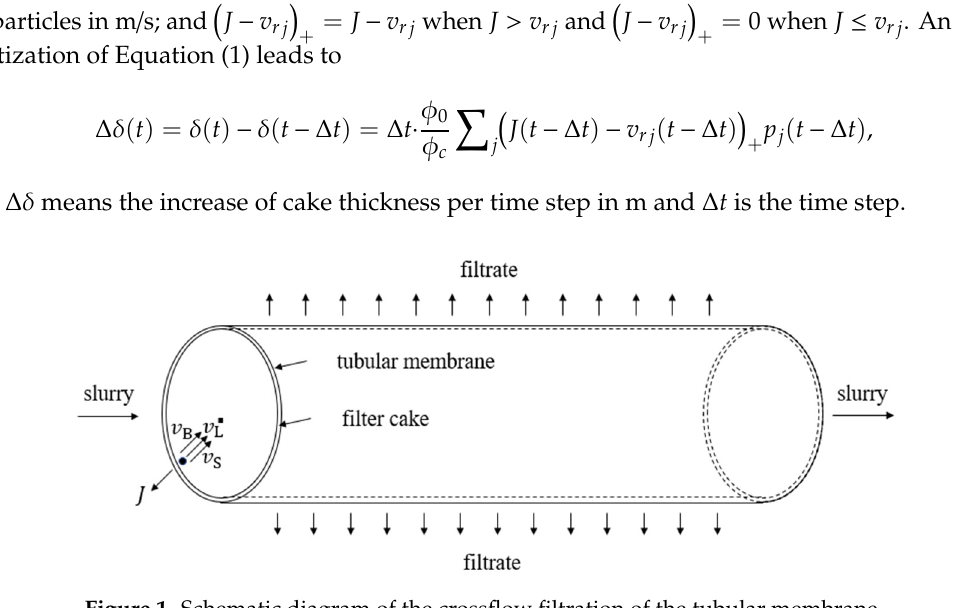
Figure 1. Schematic diagram of the crossflow filtration of the tubular membrane.